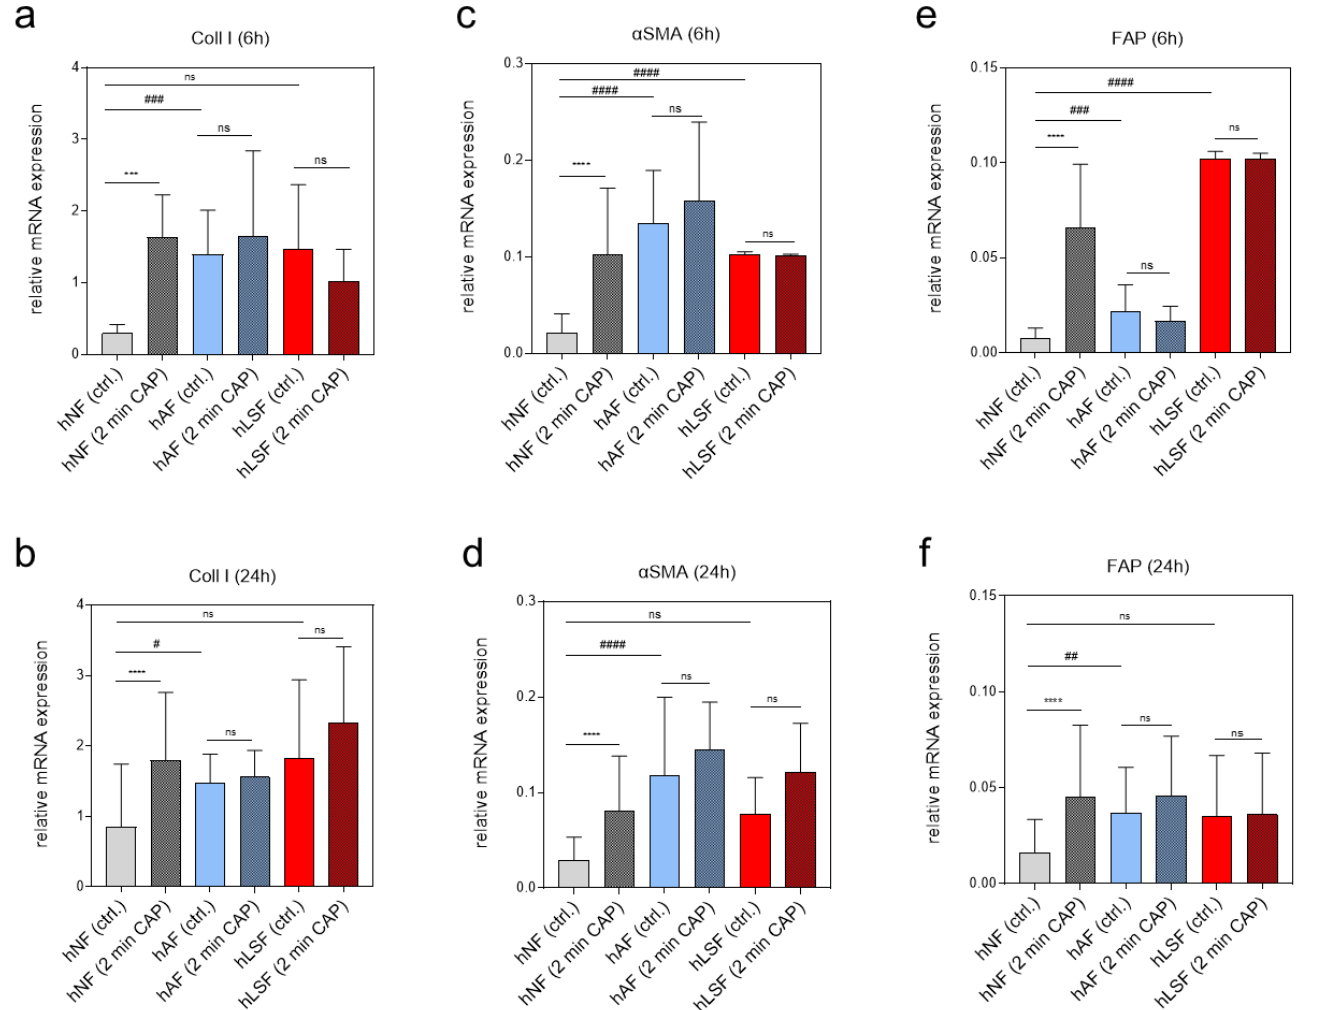
Figure 1. Effects of CAP on pro-fibrotic gene expression in normal, activated and LS-derived fibroblasts. The relative mRNA expression of Coll I ( a , b ), α SMA ( c , d ) and FAP ( e , f ) in hNF, hAF and hLSF was analyzed 6 ( a , c , e ) and 24 h ( b , d , f ) after CAP treatment. Statistical analysis: The Student’s unpaired t test and the nonparametric Mann–Whitney test were used to show differences between the medians of two groups. Significant results compared to the corresponding untreated control are indicated *** p < 0.001, **** p < 0.0001; ns = not significant. One-way ANOVA with Dunnett’s multiple comparison test was done to compare the mean of hAF and hLSF to the mean of hNF # p ≤ 0.05, ## p < 0.01, ### p < 0.001, #### p < 0.0001; ns = not